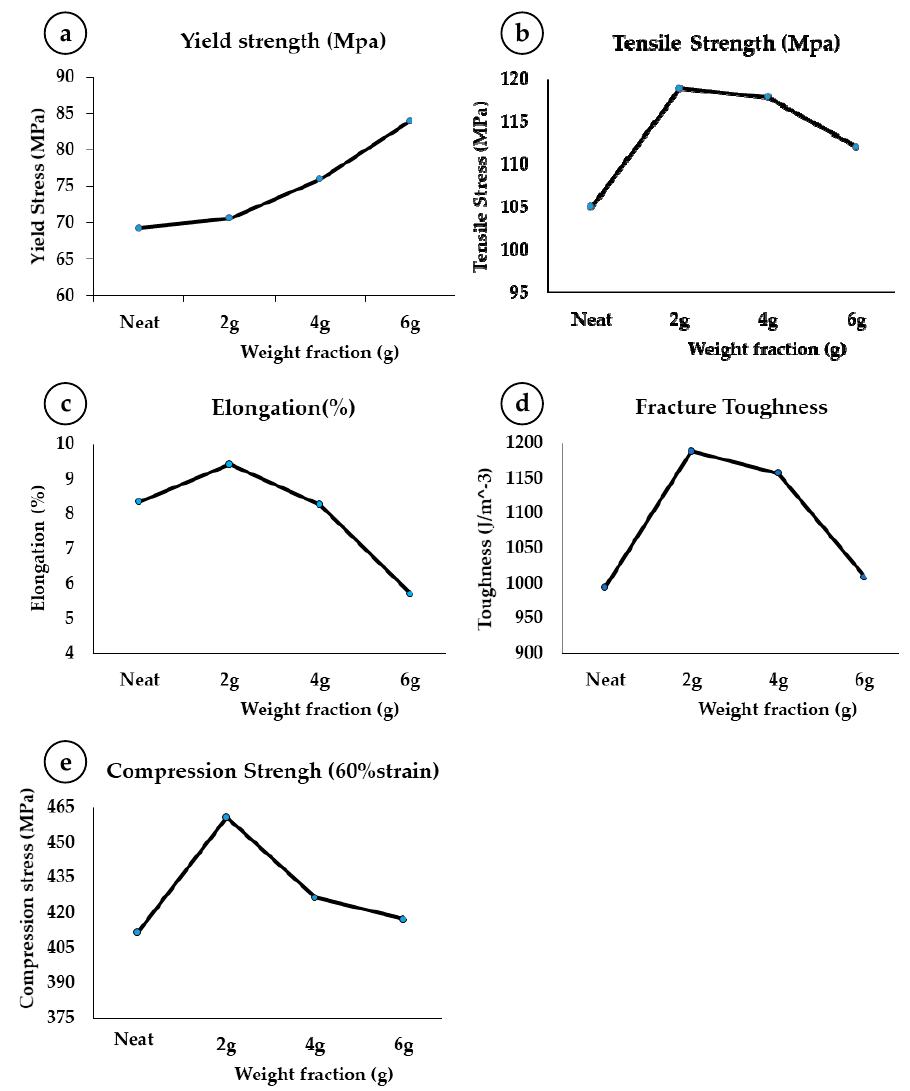
Figure 13. The values of ( a ) yield strength, ( b ) tensile strength, ( c ) elongation at break, ( d ) fracture toughness, as well as ( e ) compression strength for all monolithic and composite samples.